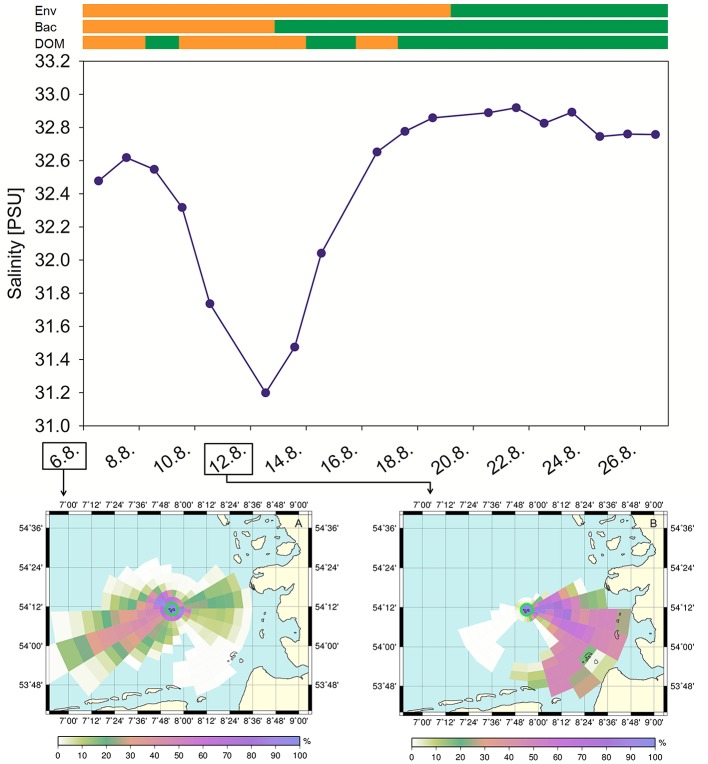
Histories of water bodies observed at Helgoland Roads. Based on pre-calculated near surface current velocities from the hydrodynamic model BSHcmod, 500 passive tracer particles were tracked backward in time. Referring to a cobweb like grid structure, the color scale reflects the percentage of particle trajectories that touched a given grid cell at any time within the past 3 weeks. Bars on top depict group formation for environmental parameters (Env), bacterial communities (Bac) and DOM. Orange, group A; Green, group B.